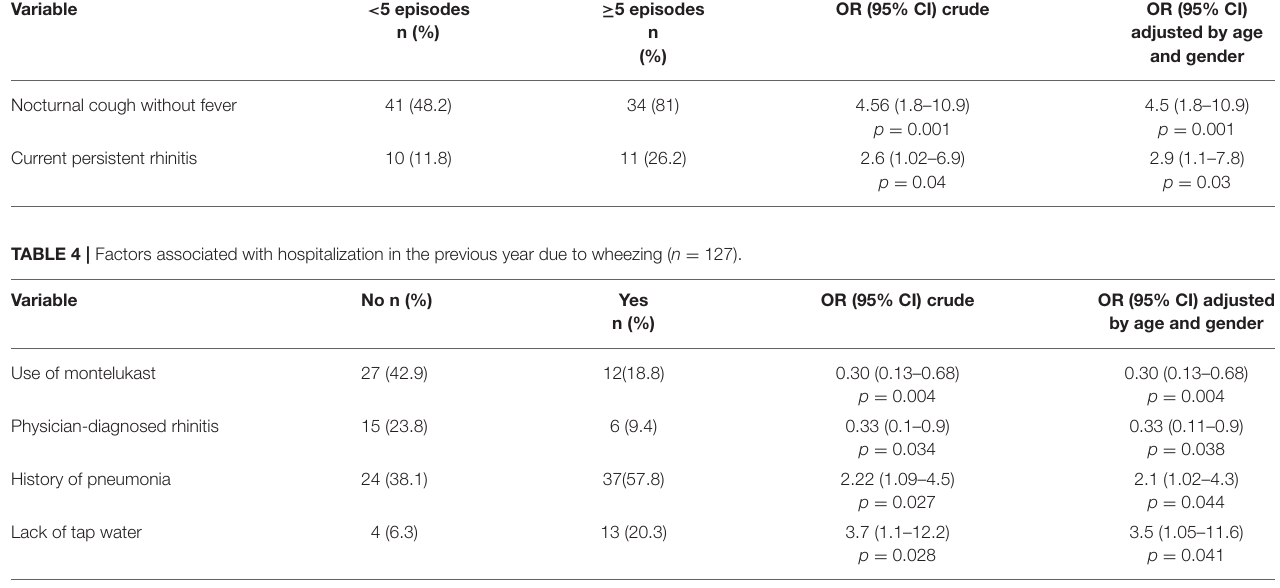
TABLE 3 | Factors associated with more than five ER visits due to wheezing ( n = 127).